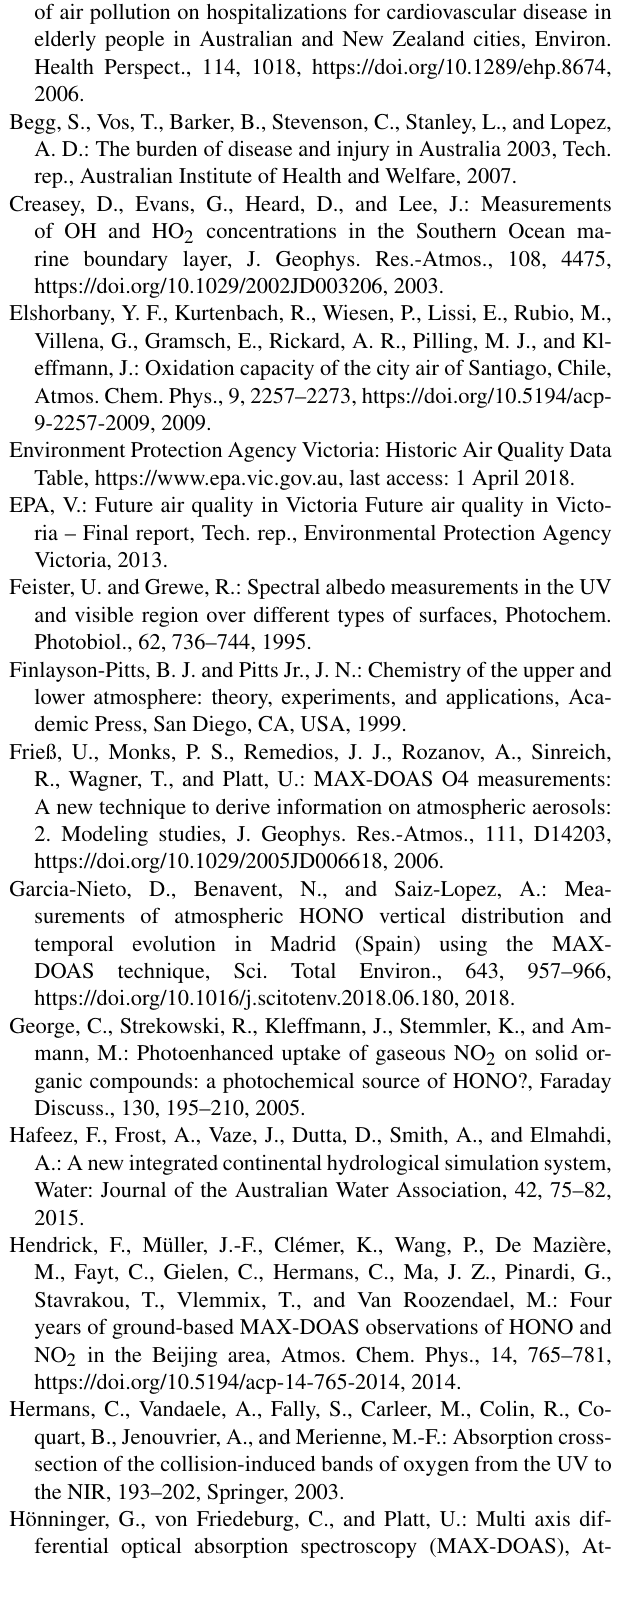
Table, https://www.epa.vic.gov.au, last access: 1 April